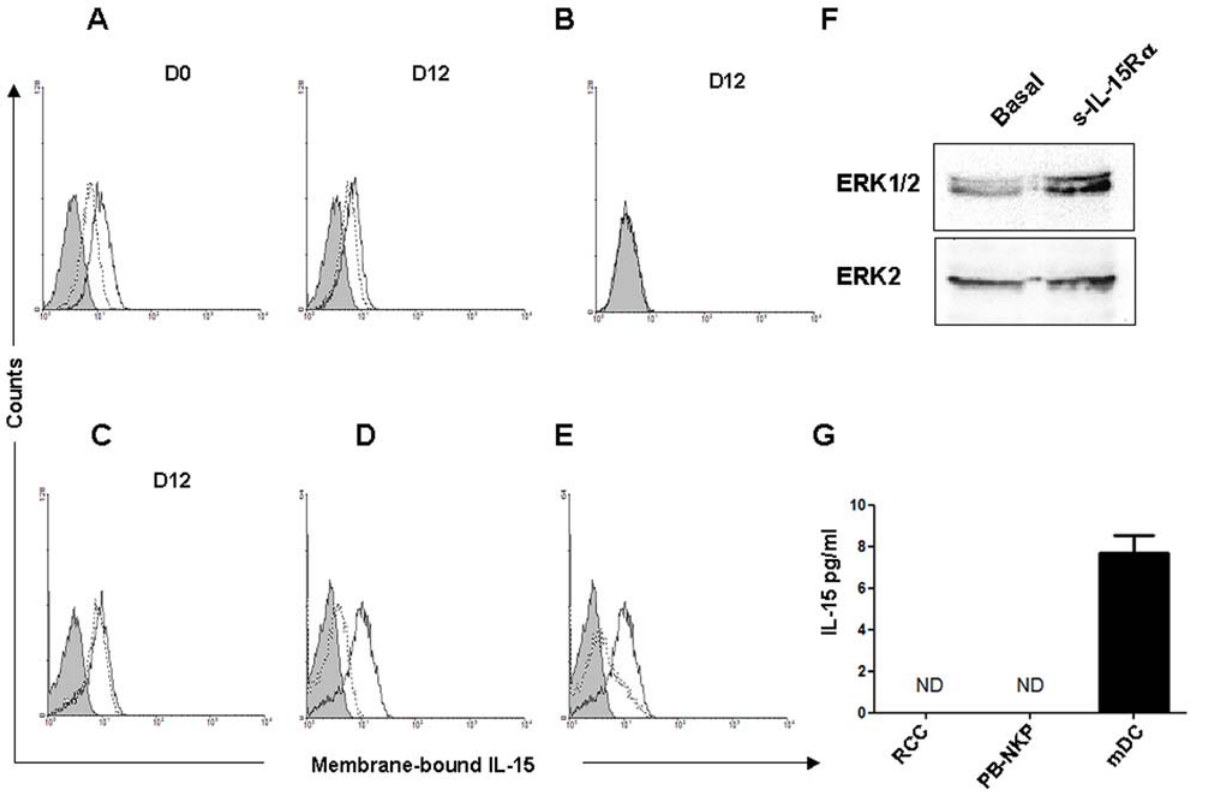
Figure 1. Membrane-bound IL-15 detection on proliferating human circulating CD34 + HP. CD34 + PB- and BM-HP were committed to the NK cell lineage, culturing in STEM a A medium supplemented with 100 ng/ml of FL and KL. The presence of membrane-bound IL-15 was evaluated staining the cells with anti-IL-15 mAb 247-PE (continuous line) or isotype-matched control Abs (shadowed peaks), followed by FACS analysis. (A) Constitutive expression and effect of the treatment at 37 u c with 10 m g/ml of neutralizing mAbs directed against the IL-15R a subunits (dotted lines). (B) No mb-IL-15 expression on BM-NKP. ( C ) PB-NKP cells were also treated with acidic buffer (pH 3.5; dotted lines) which does not modify their mb-IL- 15 expression. (D, E) In contrast, acidic shock and treatment with neutralizing anti-IL-15R a mAbs cause the suppression of mb-IL-15 form expressed by the erythroleukemic cell line TF1. ( F ) Induction of mb-IL-15-dependent reverse signal. Western Blot analysis of MAPKinase ERK1/2 activation after 15 minutes treatment of PB-NKP with the soluble recombinant IL-15R a . ( G ) ELISA assay shows that PB-NKP do not secrete IL-15. RCC and mDC supernatants were used as negative and positive controls of secretion respectively.